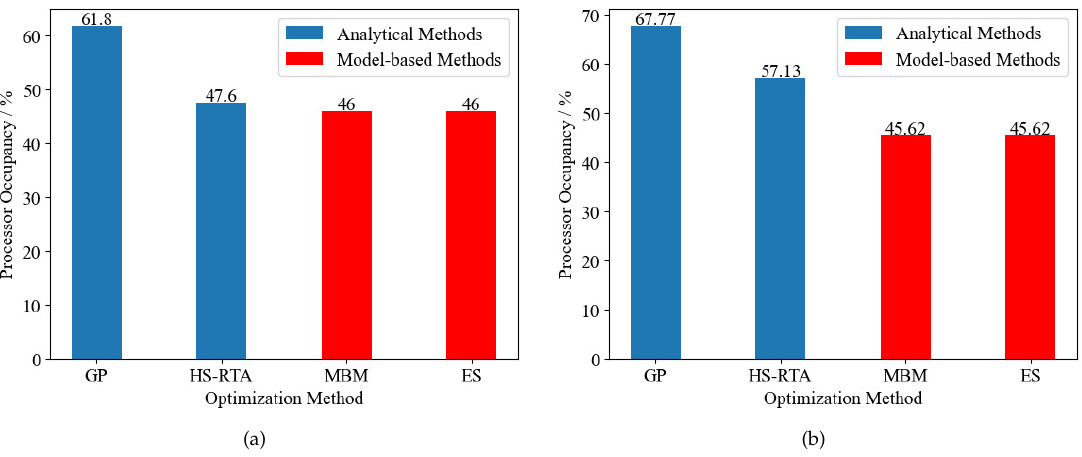
Figure 11. Processor occupancy of output solutions in comparison experiment. ( a ) System 1 with workload 35.2%. ( b ) System 2 with workload